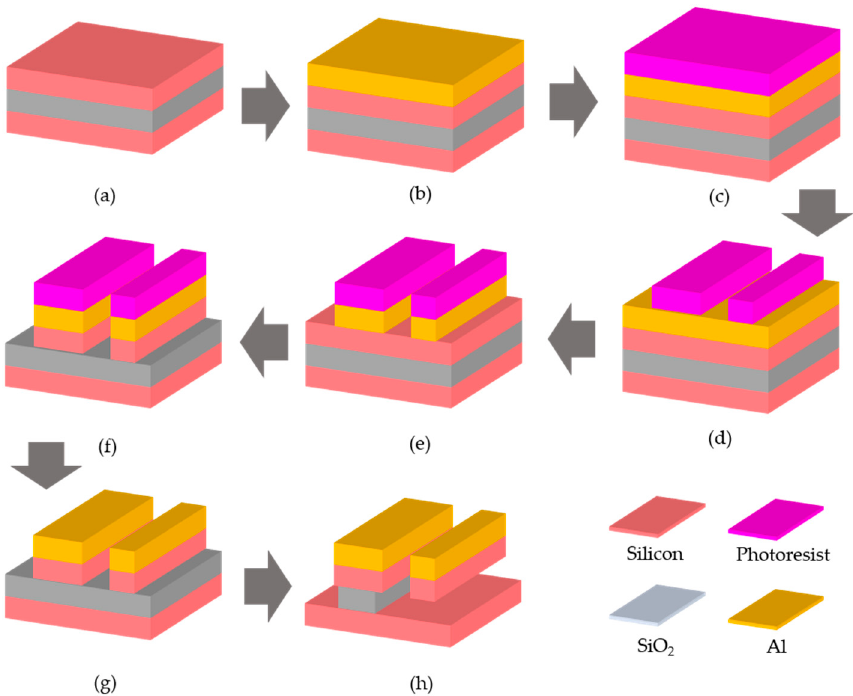
Figure 6. Fabrication process flow of a MEMS metasurface driven by electrostatic force, which is working at THz region. The metasurface and MEMS actuators are fabricated using the same deep reactive iron etching (DRIE) process. The movable structures are dependent on the release processes, including the chemical solution used and the control of the release time.